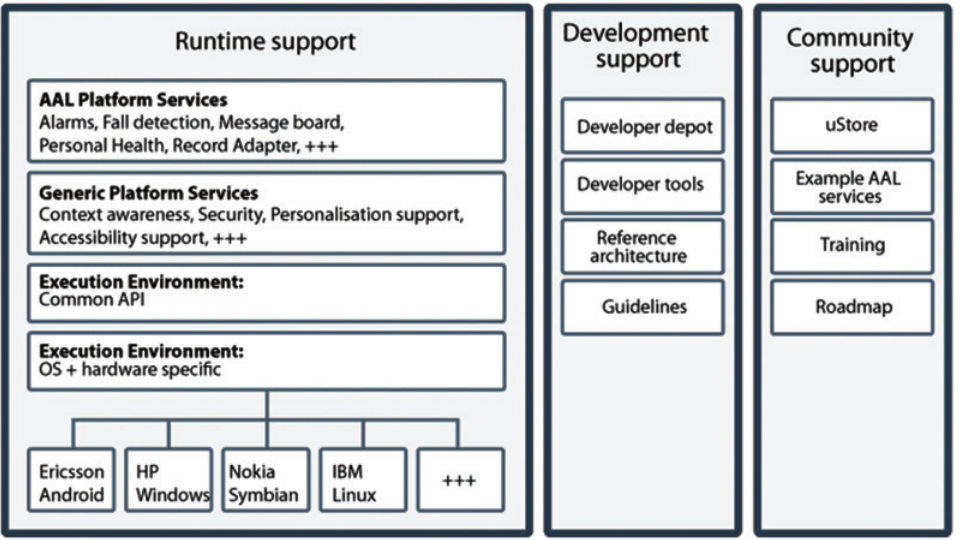
Figure 1: Overview of the UniversAAL Platform and Its